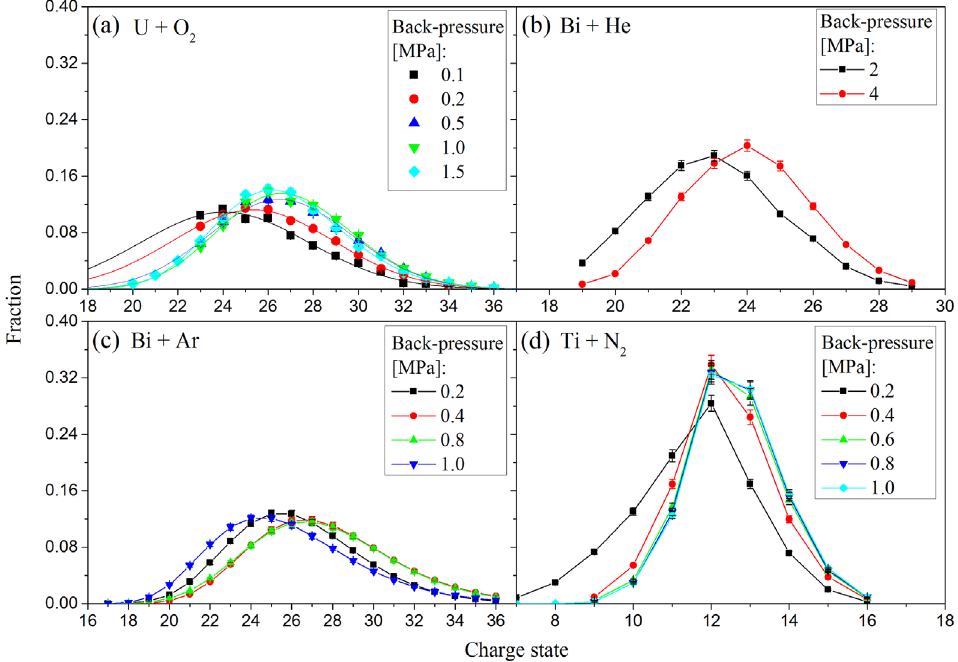
FIG. 7. Charge state distributions for 238 U on O 2 (a), 209 Bi on He (b), and Ar gas (c) as well as 50 Ti on N 2 gas (d) at 1 . 4 MeV = u for different back-pressures on the valve. For (a) and (c) the fit is shown, which was used to obtain missing charge fractions, as described in the text. For (b) and (d) lines were added to guide the